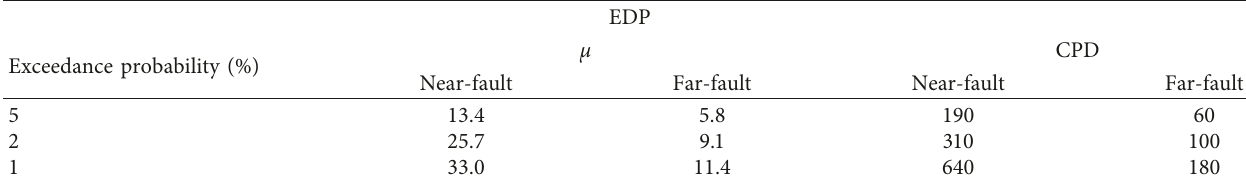
Figure 17: PSDCs of the BRB CPD: (a) near-fault ground motion group; (b) far-fault ground motion group. Table 4: Ductility and CPD demand of an HPBRB.